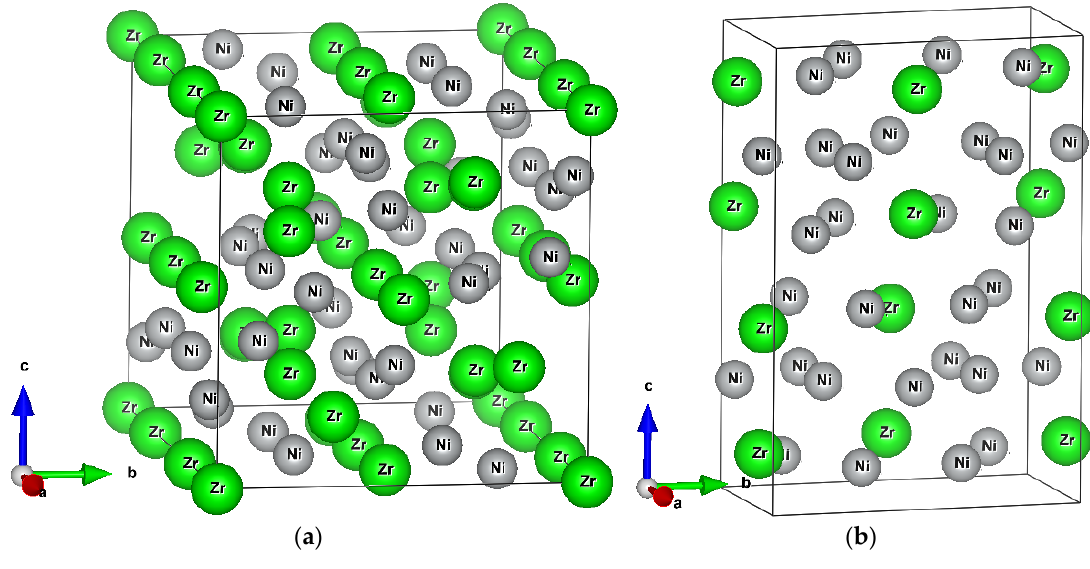
Figure 1. Unit-cell crystal structures for ( a ) Zr 7 Ni 10 and ( b ) Zr 2 Ni 7 .